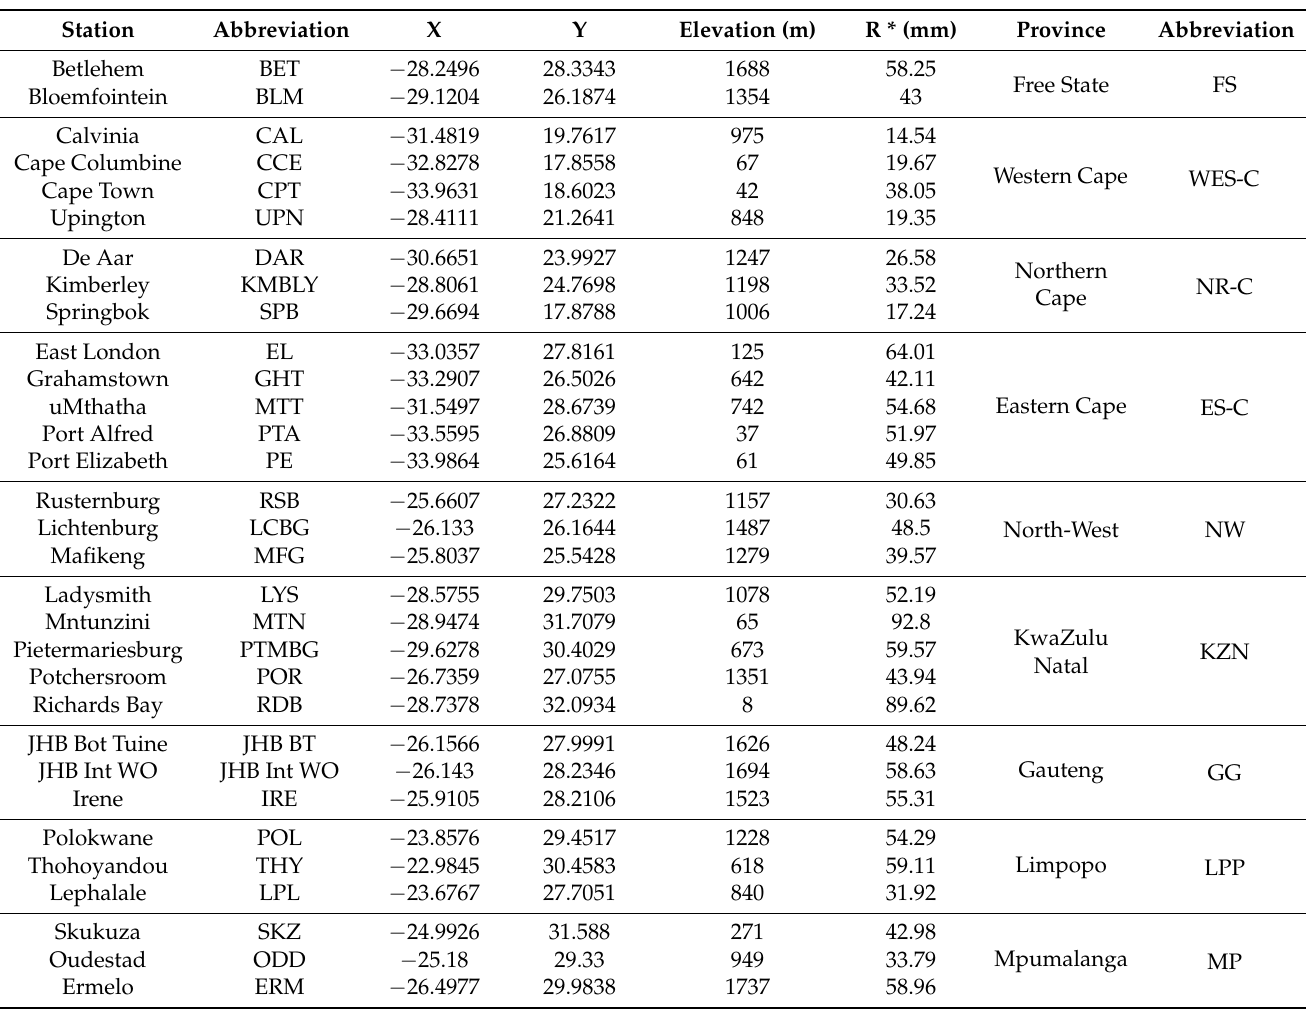
Table 1. Full overview of the analyzed meteorological stations in South Africa